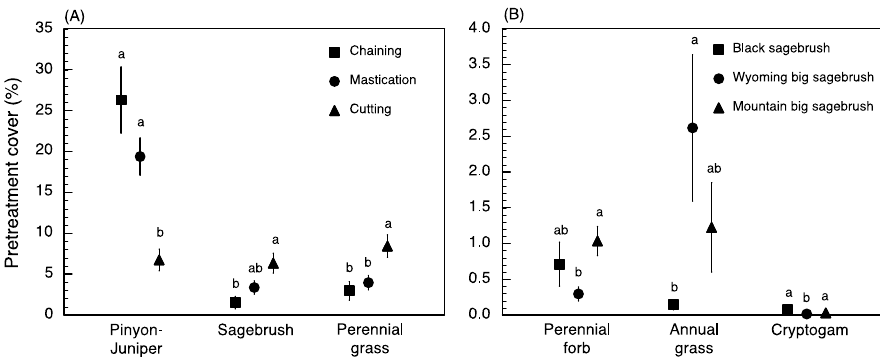
Figure 1. Mean (± SE) pretreatment cover showing differences among treatments ( A ) and plant community types (i.e., black sagebrush ( Artemisia nova ), Wyoming big sagebrush ( A. tridentata ssp. wyomingensis ), and mountain big sagebrush ( A. tridentata ssp. vaseyana ]) ( B ).